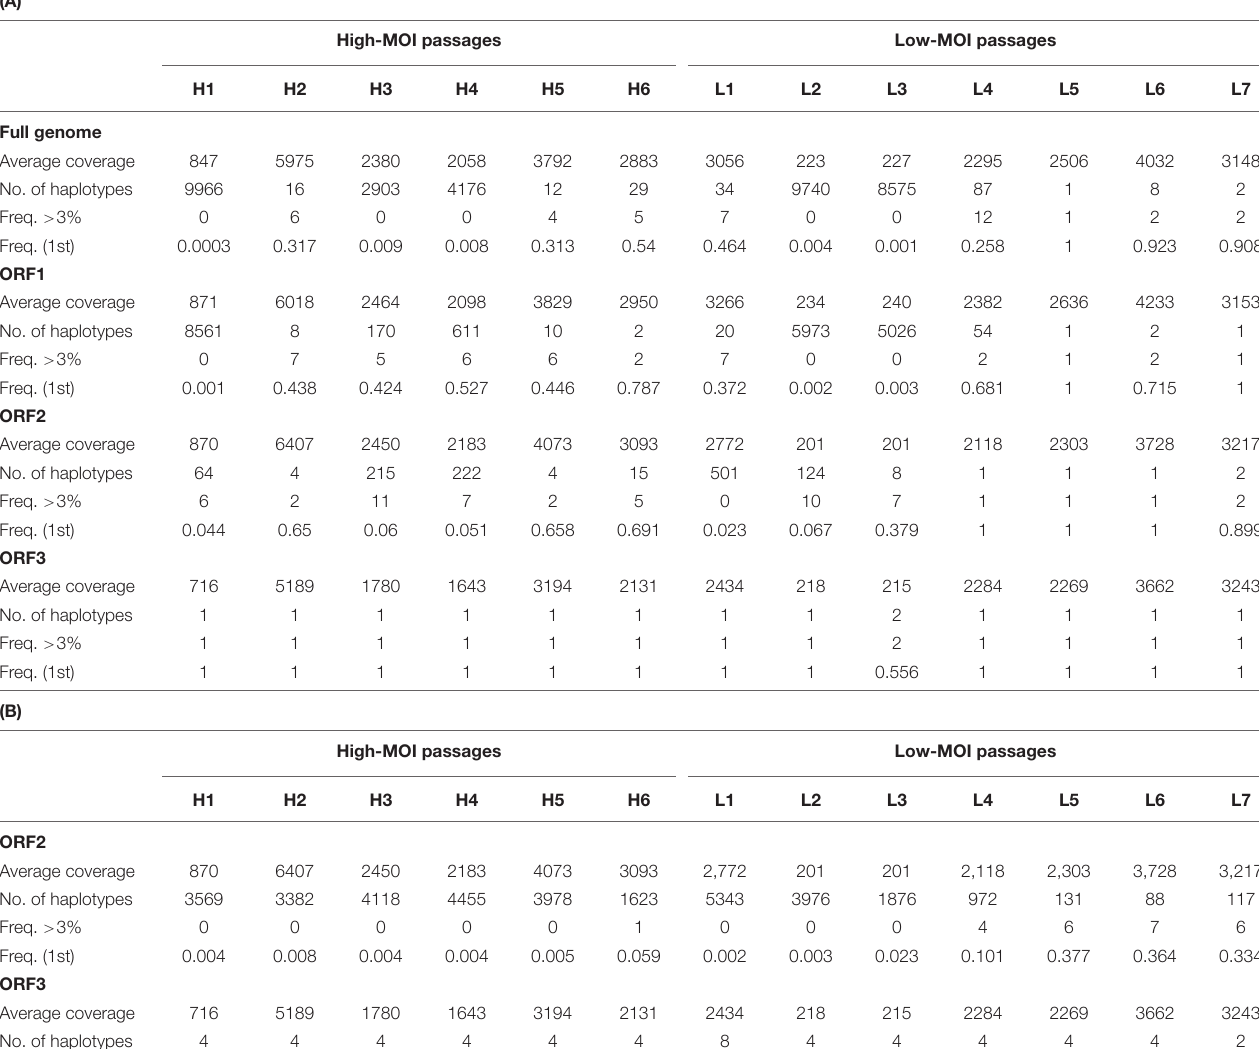
TABLE 1 | Haplotype frequencies generated by QuasiRecomb.